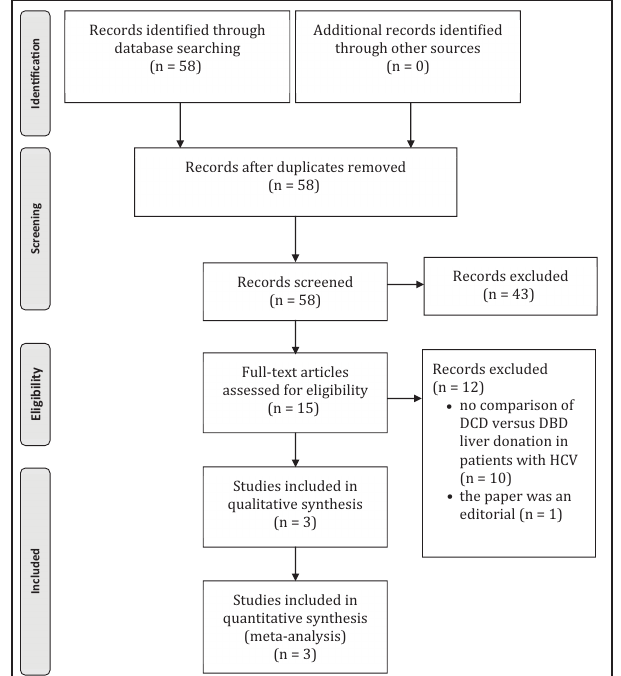
Figure 1) Study selection. DBD Donation after brain death; DCD Donation after cardiac death; HCV Hepatitis C